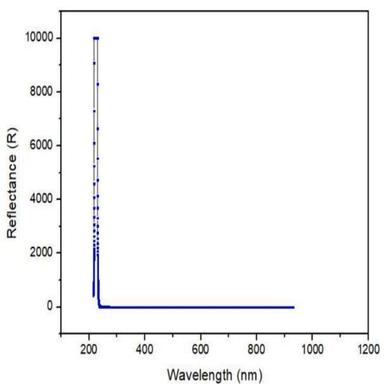
Graph exhibiting the relation between reflectance and wavelength of G4C3NBM.